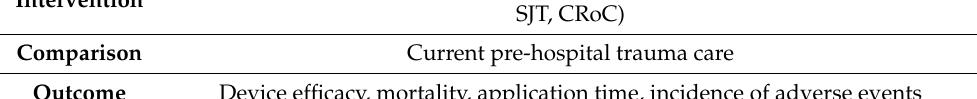
Table 1. Population, intervention, comparison, and outcome table. Trauma patients or perfused human cadaver models with catastrophic Population Intervention Comparison